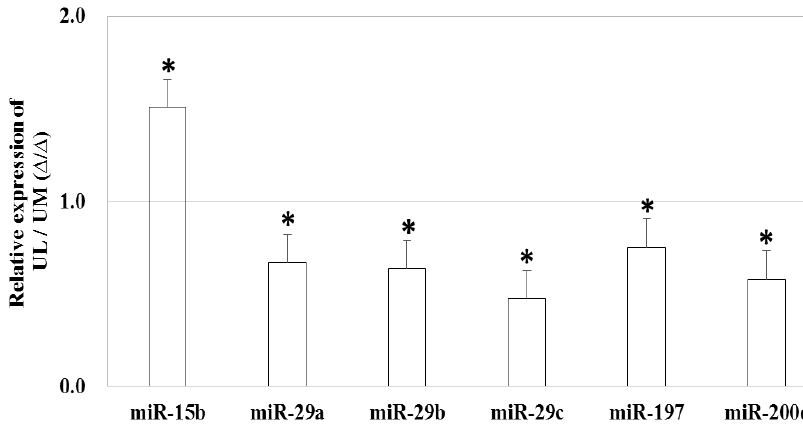
Figure 1. The relative miRNA expression in uterine leiomyoma cells compared to uterine myometrial cells (* p < 0.05).